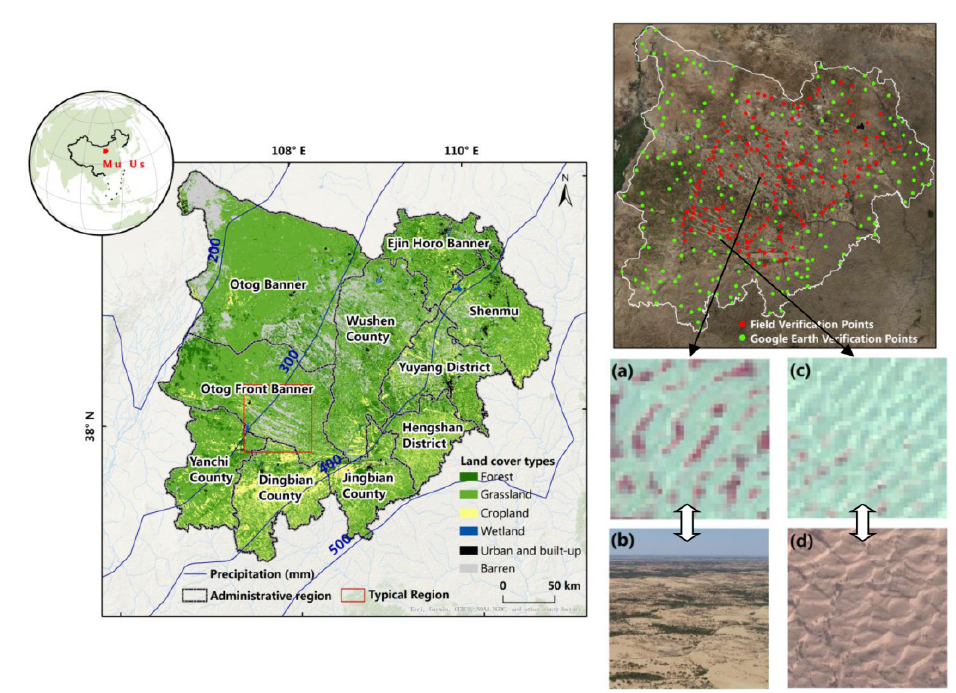
Figure 1. Study area. The information on precipitation, land cover, administrative division and verification points are shown. The 400 verification points include 191 field verification points and 209 Google Earth verification points. Field working time: 2015-07 to 2015-08: ( a ) Landsat OLI false-color synthesis image (S); ( b ) Field landscape photo (S); ( c ) Landsat OLI false-color synthesis image (ES); ( d ) Google Earth image (ES). S—severe desertification, ES—extremely severe desertification.